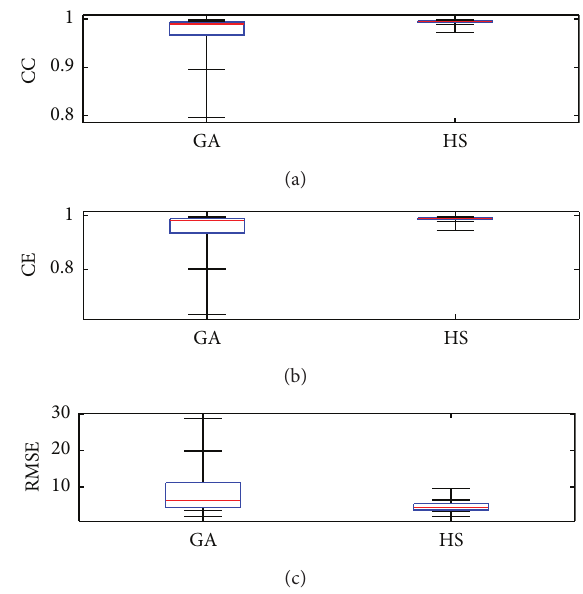
Figure 3: Boxplots of test criteria for estimated GEV parameters using 100 simulations based on GA and HS; (a) correlation coeffi- cient; (b) coefficient of efficiency; and (c) root mean square